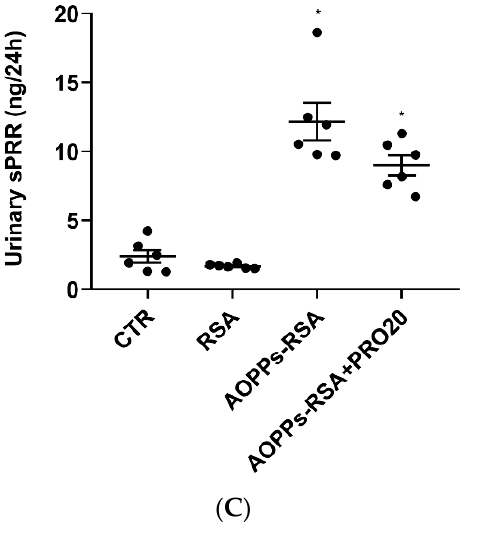
Figure 5. Expression analysis of the PRR/sPRR. Notes: ( A ) mRNA levels of PRR were measured by RT-qPCR. ( B ) Protein levels of fPRR and sPRR in renal cortex was assessed by immunoblotting. The normalized quantitative data for β -actin are shown below each blot. ( C ) Urinary sPRR excretion was analyzed with ELISA. ( D ) Plasma sPRR was analyzed with ELISA. Results are presented as mean ± SEM. n = 6 per group. * p < 0.05, compared to the CTR group. PRR: (Pro)renin receptor; fPRR: full-length PRR; sPRR: soluble PRR.